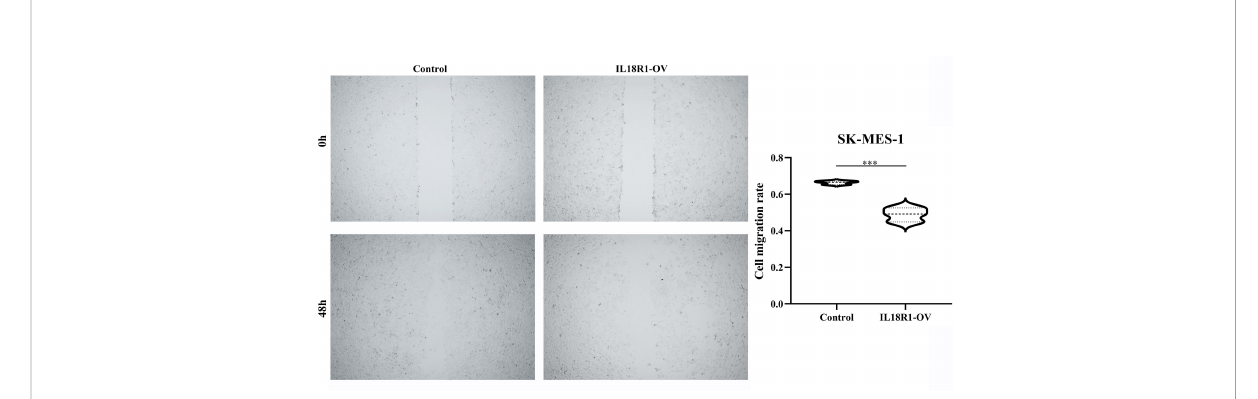
FIGURE 6 IL18R1 over-expression could inhibit the cell migration in LUSC. LUSC, lung squamous cell carcinoma; ***P <